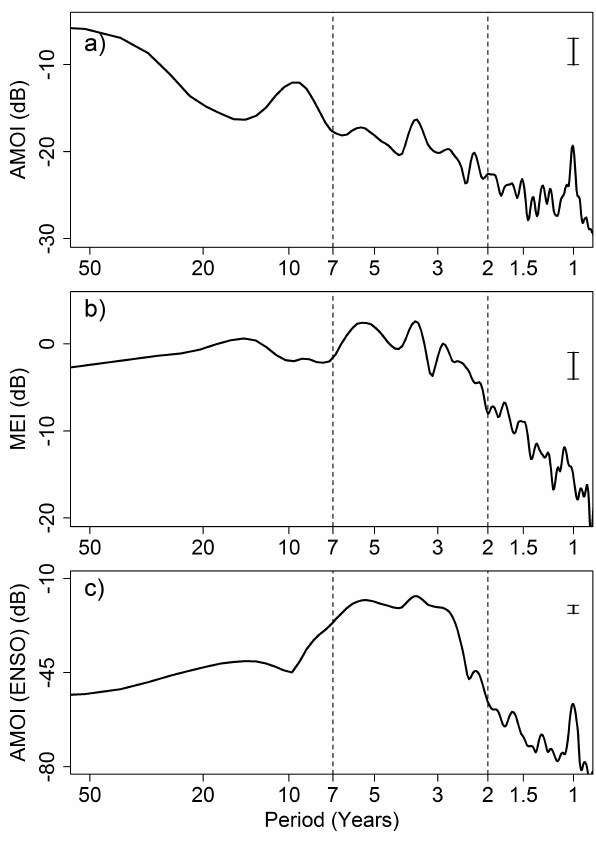
Fig. 3. Power spectral density estimates of (a) unsmoothed AMOI, (b) MEI, and (c) reconstruction of the sum of the six AMOI EOFs with dominant frequencies in the ENSO band that contribute coher- ently from MEI to AMOI. The horizontal axis is the spectral period in years. Vertical dashed lines mark ENSO band frequencies, verti- cal bar quantifies the 95% confidence interval. Table 2. Tidal stations and period of